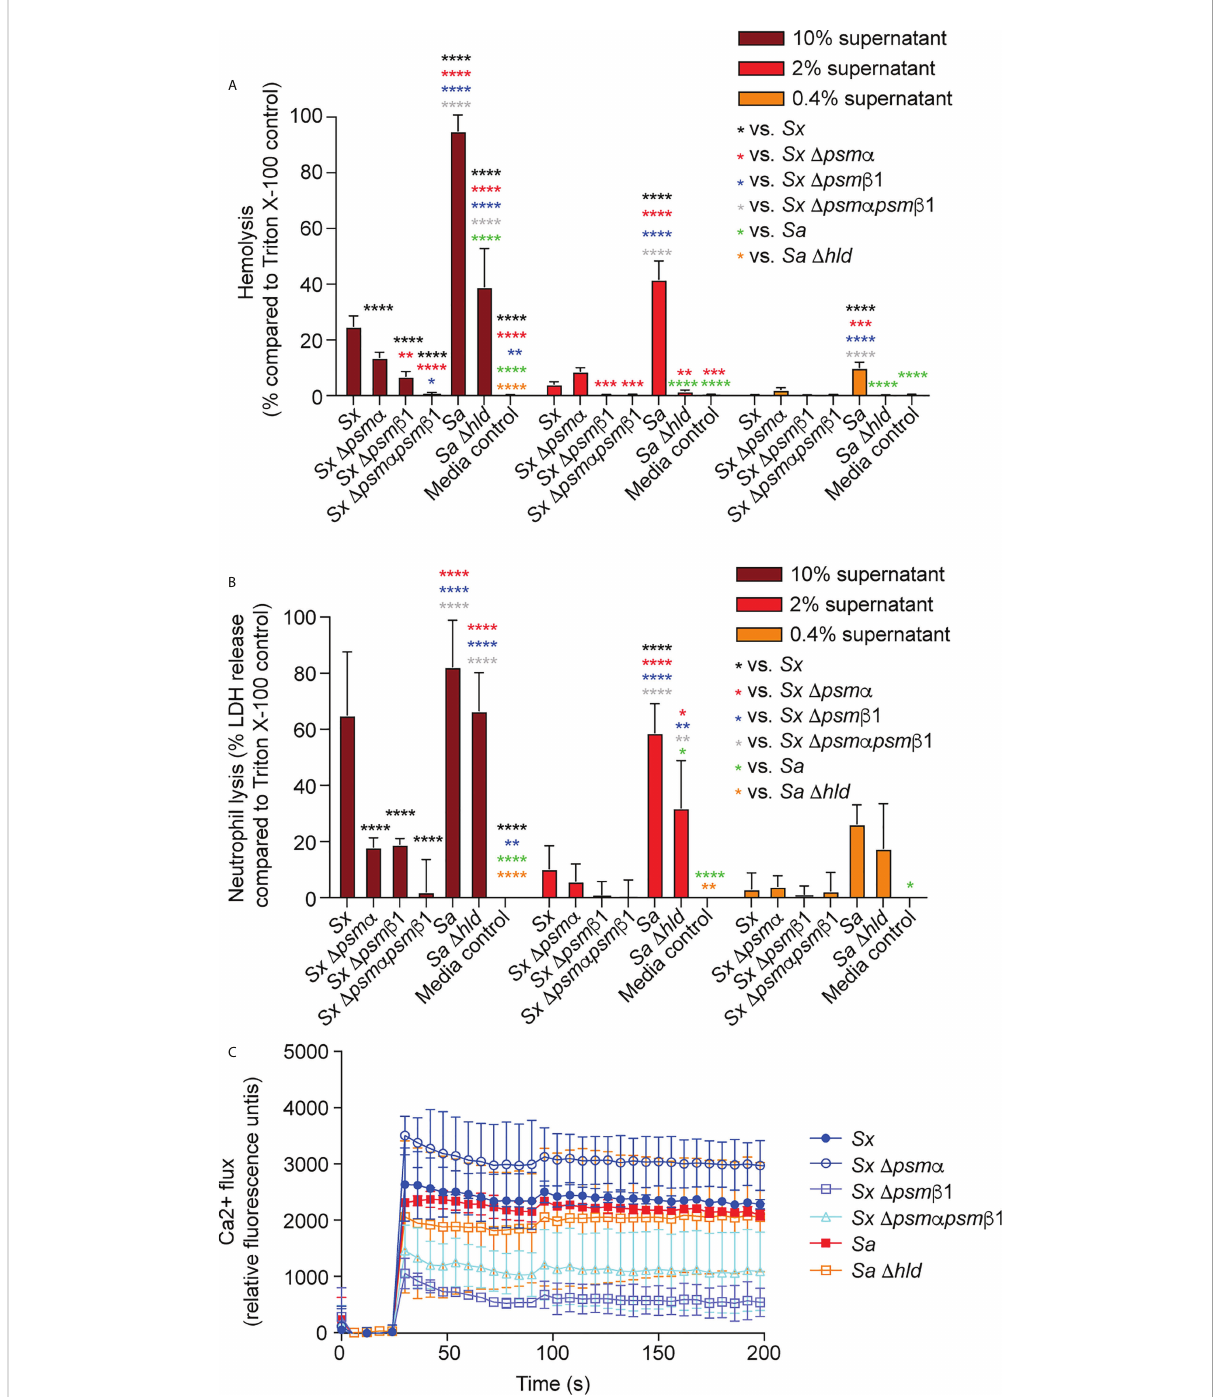
FIGURE 5 Cytolytic and pro-in fl ammatory capacities of S. xylosus psm deletion strains. Capacity of stationary-phase (16-h) culture fi ltrates from S. xylosus AG14 and isogenic psm mutants to induce lysis of (A) human erythrocytes, (B) human neutrophils and (C) induce calcium fl ux in human neutrophils. Culture fi ltrates from S. aureus LAC and its isogenic d -toxin mutant were used as comparison. For hemolysis and lactate dehydrogenase (LDH) release assays, triplicate measurements were performed using whole heparinized blood and puri fi ed neutrophils obtained from three donors, respectively. For calcium fl ux assays, single measurements were performed from two donors. Statistical analysis is by 2-way ANOVA with Tukey ’ s post-tests. *, p<0.05; **, p < 0.01; ***, p < 0.001; ****, p < 0.0001; Error bars show the mean ±